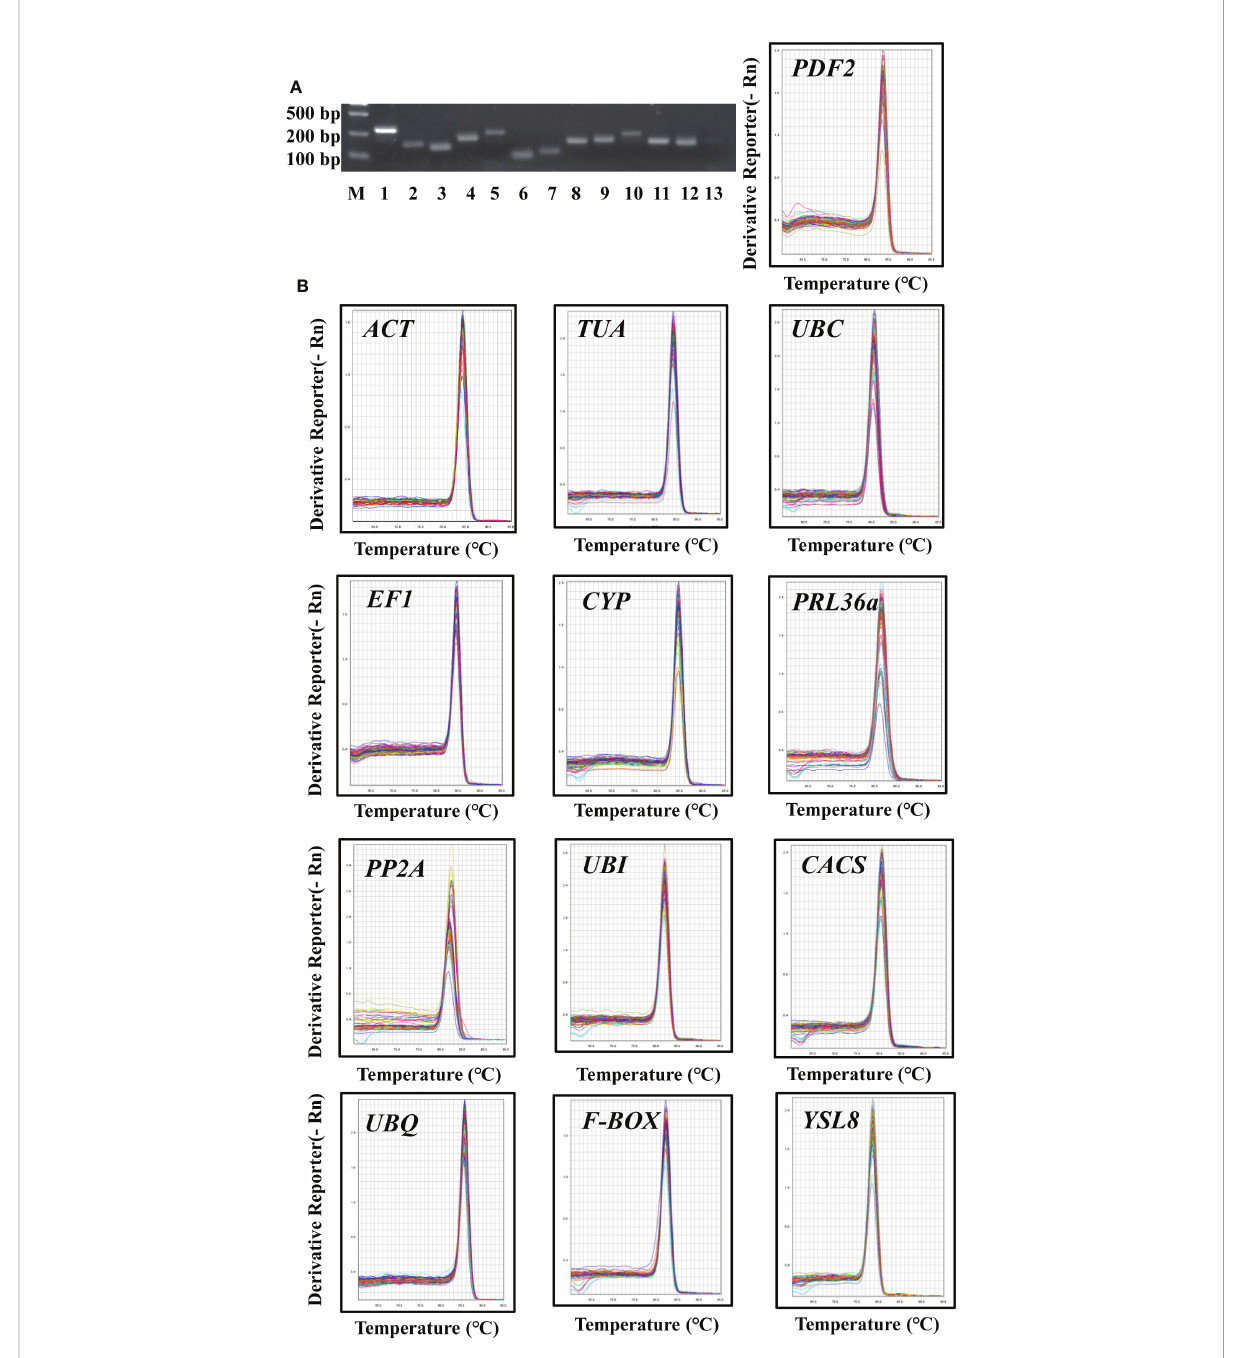
FIGURE 1 Primer speci fi city of candidate reference genes. (A) , Agarose gel analysis of RT-PCR generated amplicons for each of the thirteen assessed candidate reference genes. M, marker; 1-13, ACT , TUA , UBC , EF1 , CYP , PRL36Aa , PP2A , UBI , CACS , UBQ , F-BOX , YSL8 , PDF2. (B) , Melt curve analysis of the thirteen assessed candidate reference genes across different samples in cucumber roots showed a single peak for each primer pair at a speci fi c annealing